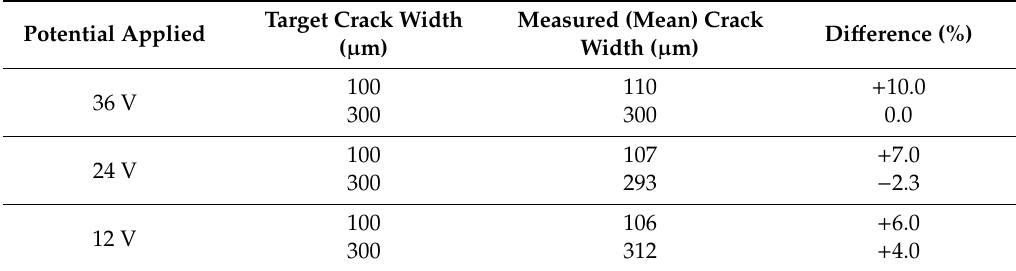
Figure 1. Preparation of cracked specimens: ( a ) splitting; ( b ) adhering silicon tapes; ( c ) reassembling. Table 3. Target and measured crack widths.